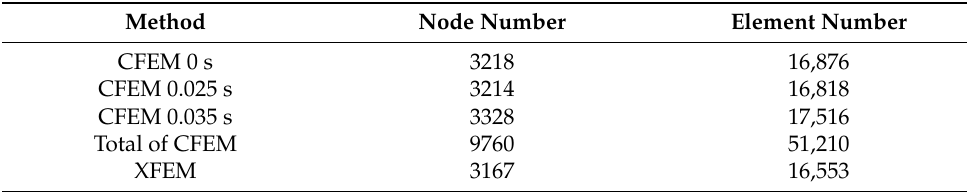
Table 10. Contrast of number of nodes and